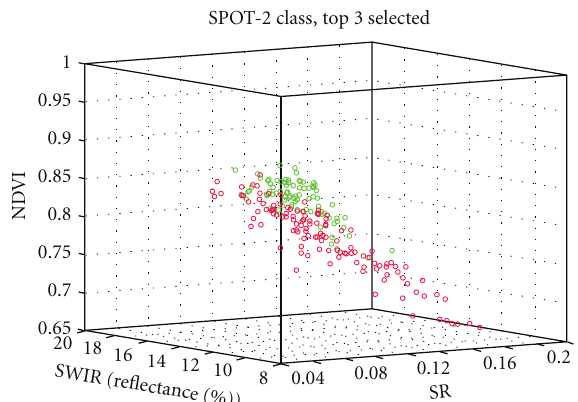
Figure 6: Values for simple ratio, the percent reflectance in the SWIR and the NDVI for individual trees infested or not infested with balsam woolly adelgid. Reflectances and band ratios were computed by integrating the narrow band data to the SPOT5- HRVIR band equivalent reflectance. The three variables were selected using a stepwise discriminant analysis procedure for distinguishing infested from noninfested